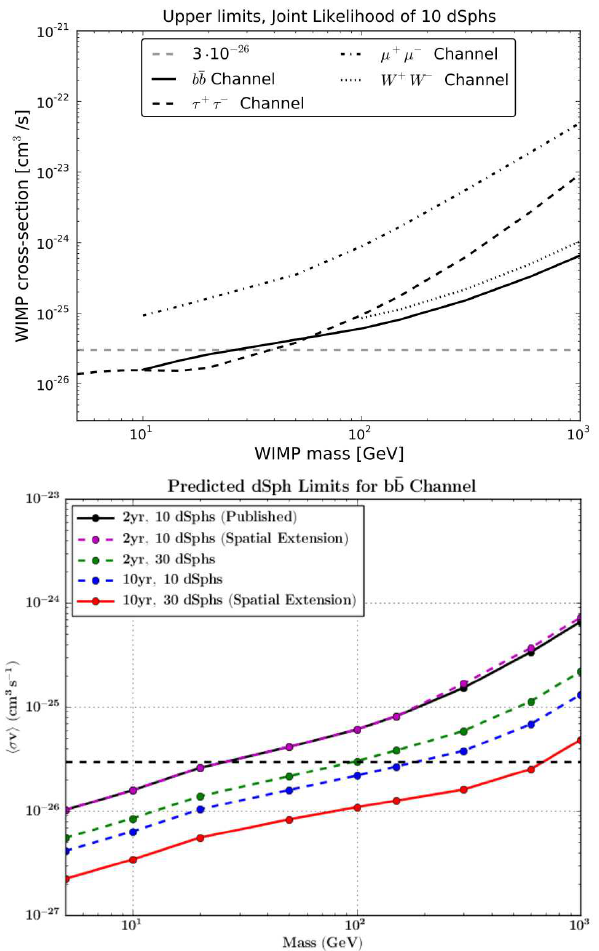
Figure 2: Derived 95% C.L. upper limits on WIMP annihilation cross sections for different channels. down: Predicted 95% C.L. upper limits on WIMP annihilation cross sections in 10 years for bbar channel.